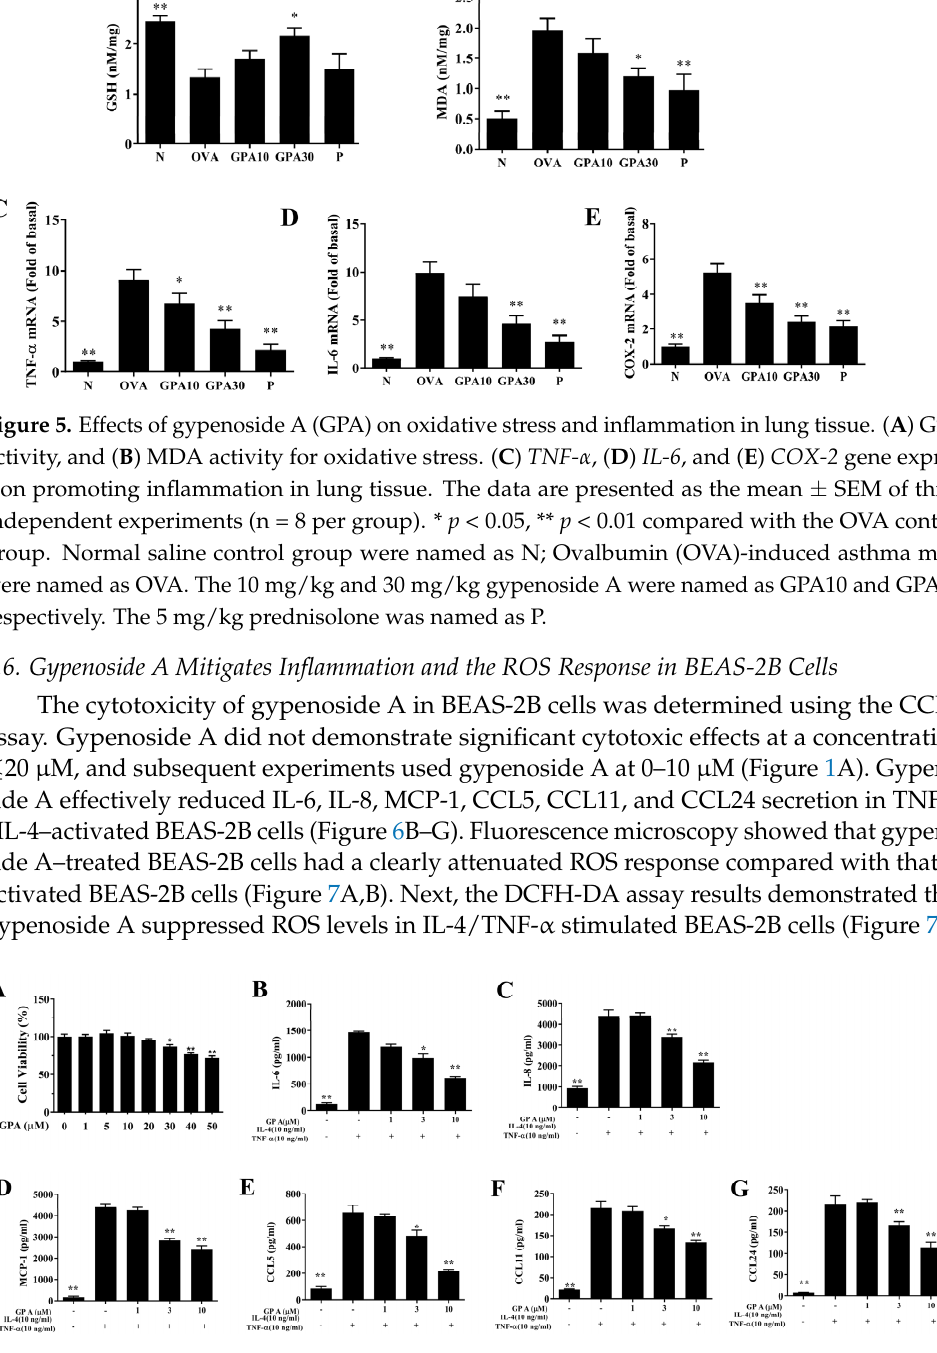
Figure 7. Effects of gypenoside A (GPA) on ROS production in activated BEAS-2B cells. ( A ) Fluo- rescence microscopy images of intracellular ROS (scale bar = 100 µm). ( B ) Fluorescence intensity of intracellular ROS. ( C ) ROS levels detected in TNF- α /IL − 4-activated BEAS-2B cells with or without gypenoside A as percentages of the levels in untreated cells (N). The data are presented as the mean ± SEM of three independent experiments. * p < 0.05, ** p < 0.01 compared to BEAS-2B cells stimulated with TNF- α /IL-4.